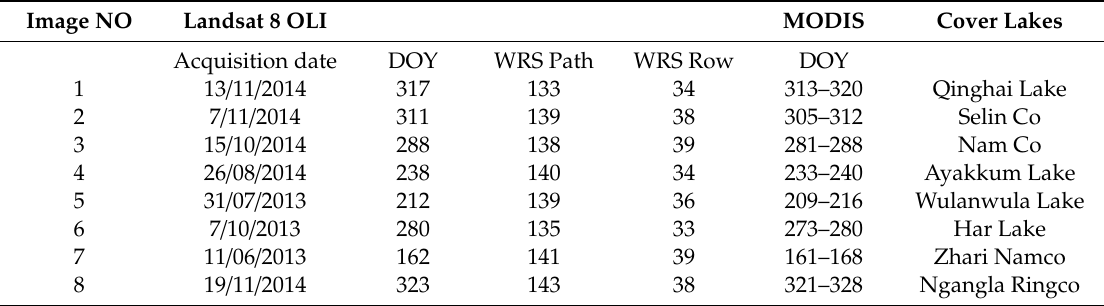
Table 1. Pairs of Operational Land Imager (OLI) / Moderate Resolution Imaging Spectroradiometer (MODIS) images used for the validation of the water mapping algorithm. Abbreviations: DOY, Day